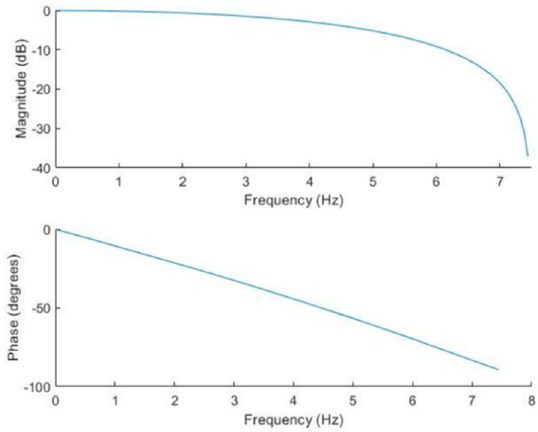
Figure 8. Frequency response curve of digital filter.